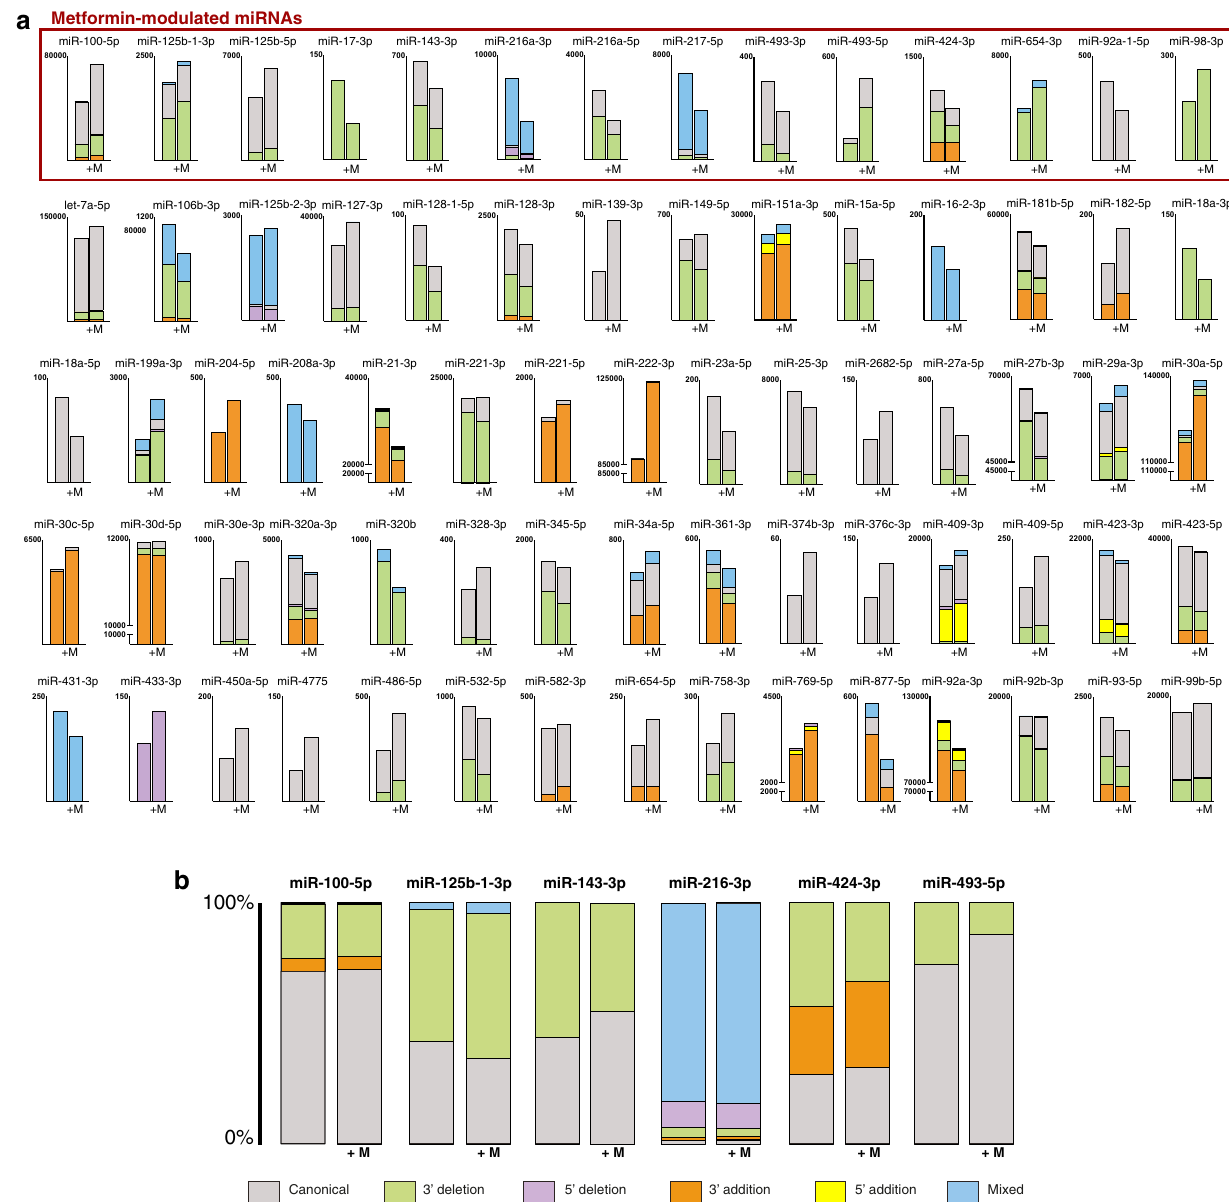
Figure 4. Proportions of isomiR variations within miRNAs modulated by metformin. ( a ) Comparison of normalized reads of the different types of isomiR variations of miRNAs including at least one isomiR differentially regulated by metformin. The 14 metformin-modulated miRNAs including at least one differentially regulated isomiR are highlighted. ( b ) Proportions of isomiR variation types within 6 out of the 27 miRNAs differentially regulated by metformin showing significant isomiR redistribution between SEN and SEN +